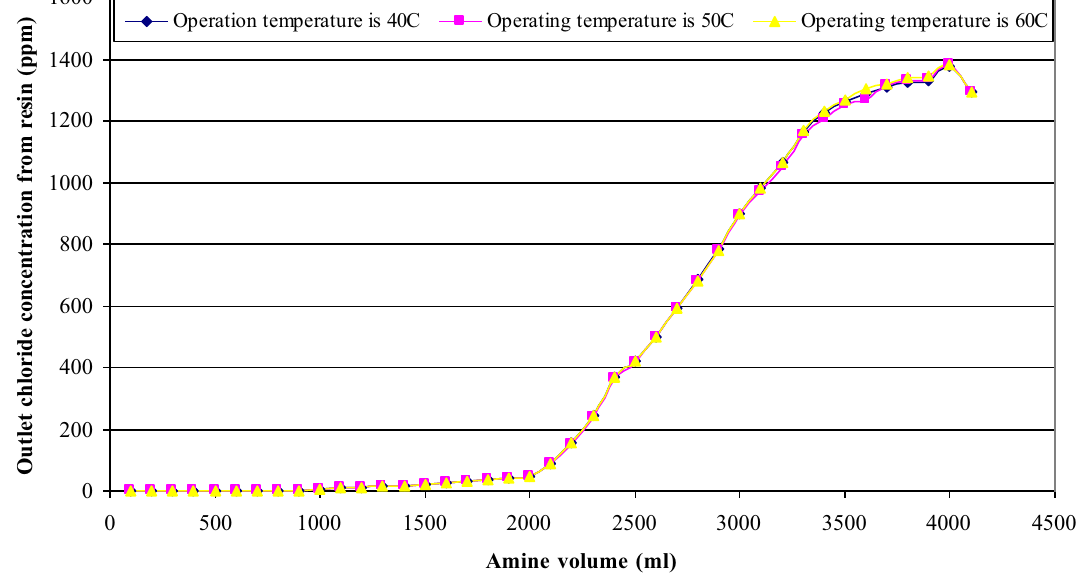
Fig. 1 Concentration of chloride leaving the resin bed versus volume of passing